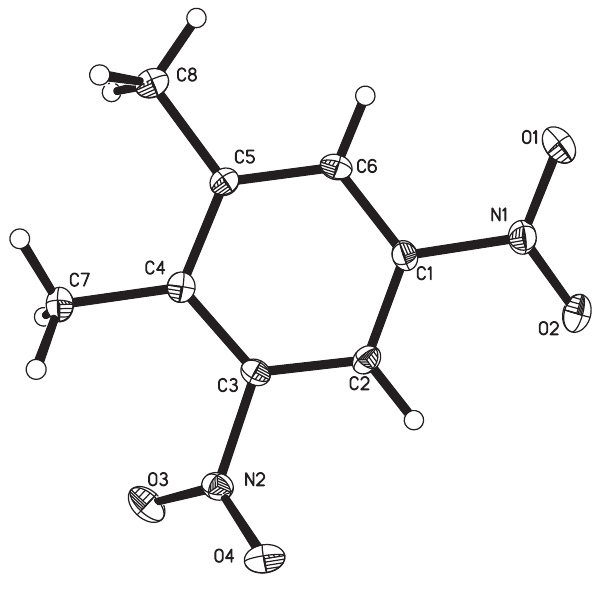
Table 1: Data collection and handling.